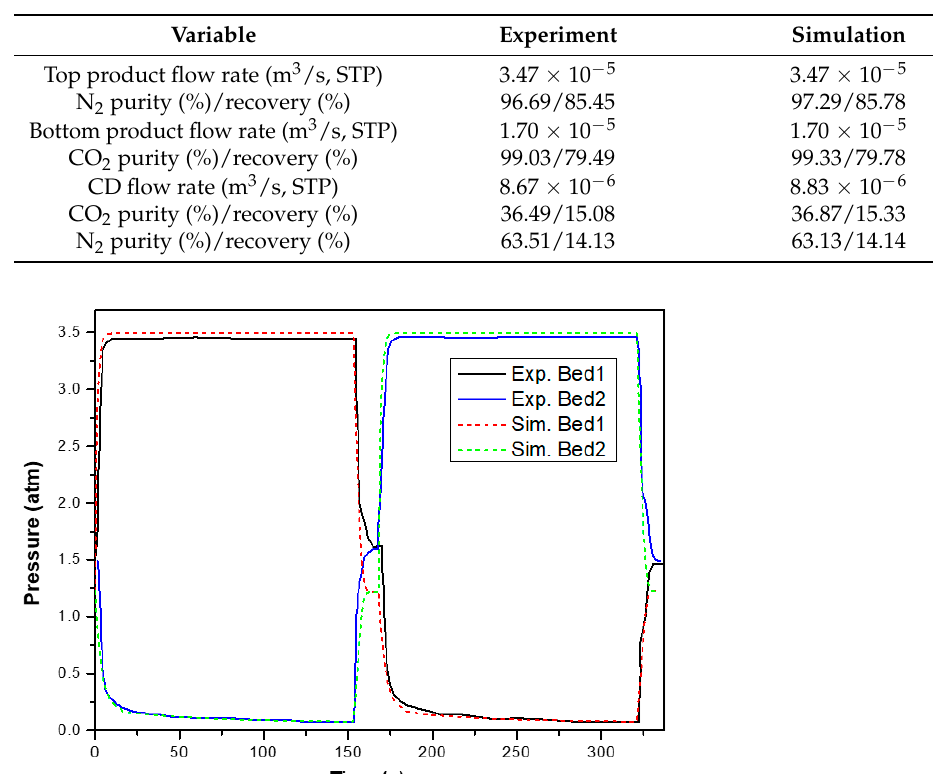
Table 13. Simulation results of the basic case PSA process.